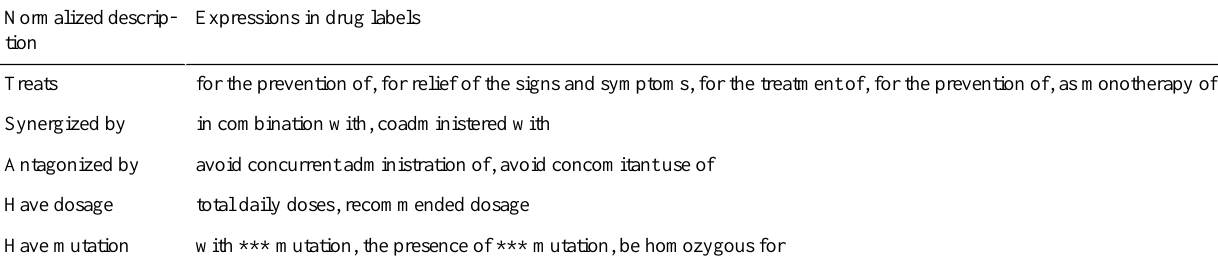
Table 5. Examples of semantic relationship–normalized